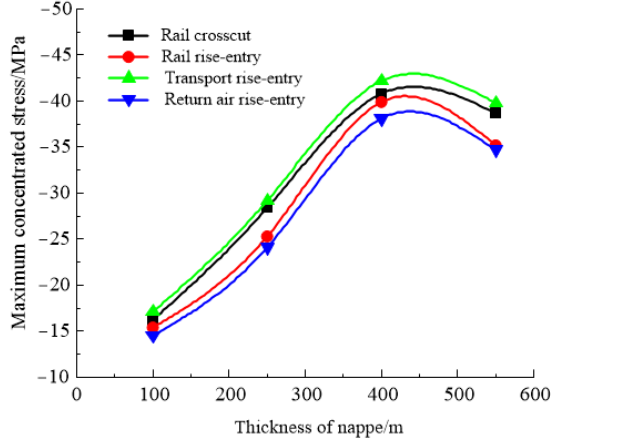
( b ) Figure 10. Monitoring results of convergence in roadway-concentrated areas under the different thicknesses of nappe conditions. ( a ) Roof-to-floor convergence, ( b ) Two-sided convergence. It can be seen from Figure 10 that the thickness of the nappe had the same influence on the changing trend of the roof-to-floor convergence and the two-sided convergence in the roadway-concentrated areas under the super-thick nappe, both showing a trend of